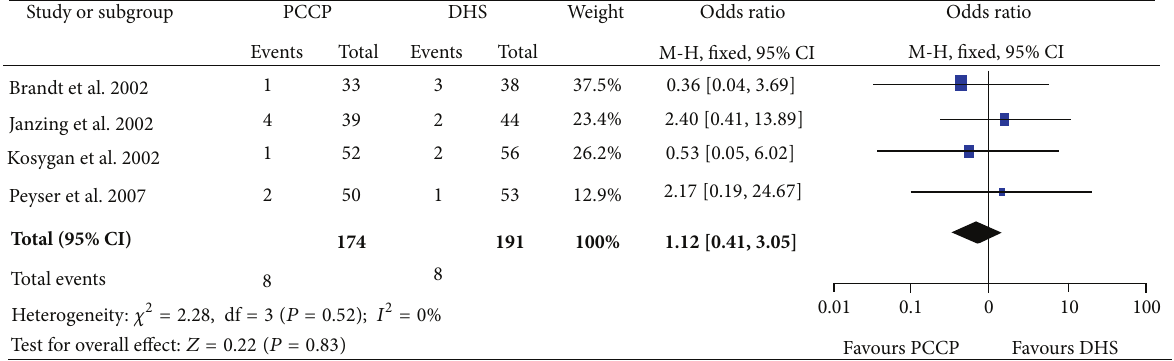
data pooled by a fixed effect model indicated no statistical significant difference between the two groups (OR: 0.62, 95% CI: 0.37 ∼ 1.02, 𝑃 = 0.06 ) (Figure